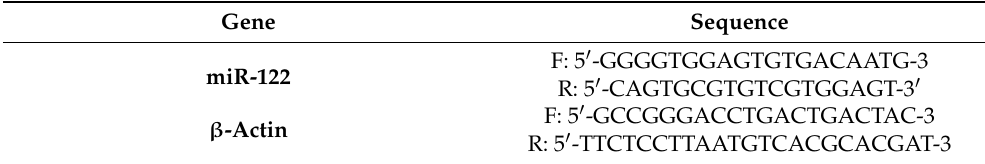
Table 1. Primers sequence for RT-PCR.